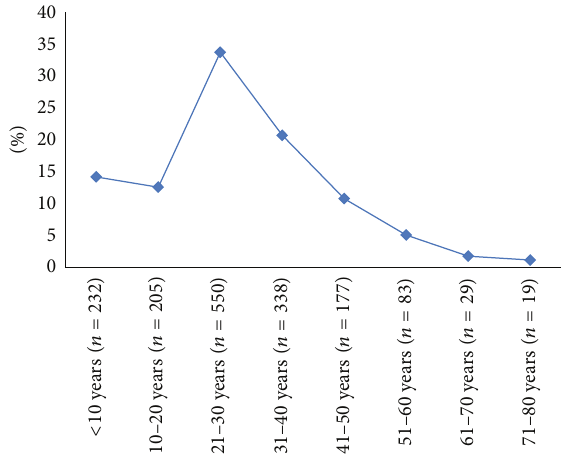
Figure 1: Head injury in different age